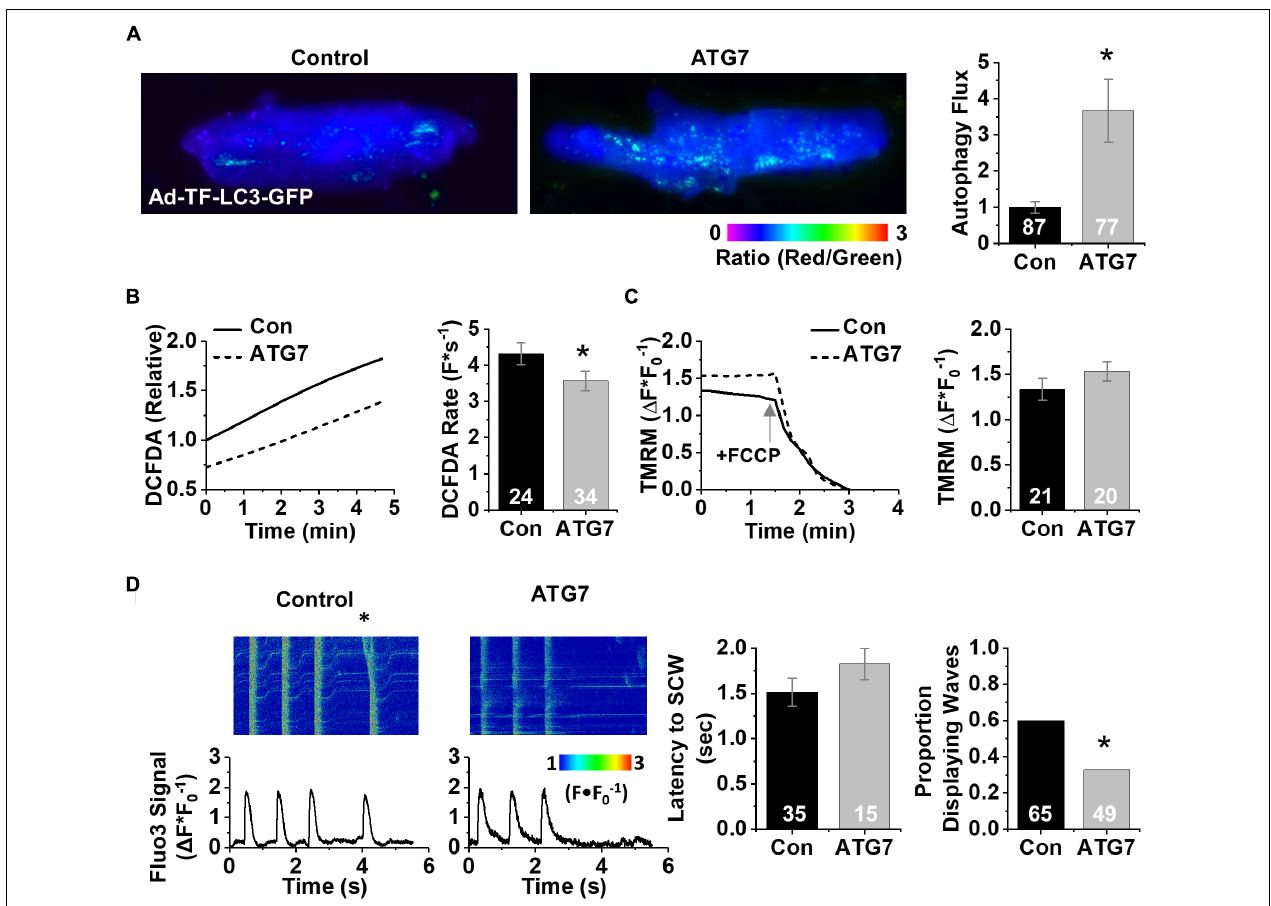
FIGURE 5 | Genetically enhancing autophagy in aged rabbit CMs reduces ROS, restores (cid:49) ψ m, and reverses effects of aging on RyR2-mediated Ca 2 + release. (A) Fluorescence images of aged rabbit CMs infected with Ad-ATG7 visualizing autolysosomes as puncta. (B) Changes in DCFDA fluorescence in ATG7 overexpression in aged rabbit CMs. Mean data represent ROS production rate. (C) Traces and mean data of normalized TMRM fluorescence of ATG7 and LacZ control-treated CMs. Data are normalized to the minimum TMRM fluorescence in the presence of the uncoupling agent FCCP (50 µ M). (D) Confocal line scan images and Fluo3 profiles at the end of 30 s 1 Hz pacing train with aged rabbit CMs treated with ATG7 or LacZ control; all with 25 nM isoproterenol. SCWs are indicated by an asterisk. Mean data for SCW latency and proportion of cells exhibiting SCWs (proportion data ∗ p < 0.05, Fisher’s exact test). ∗ p < 0.05, all values are mean ±